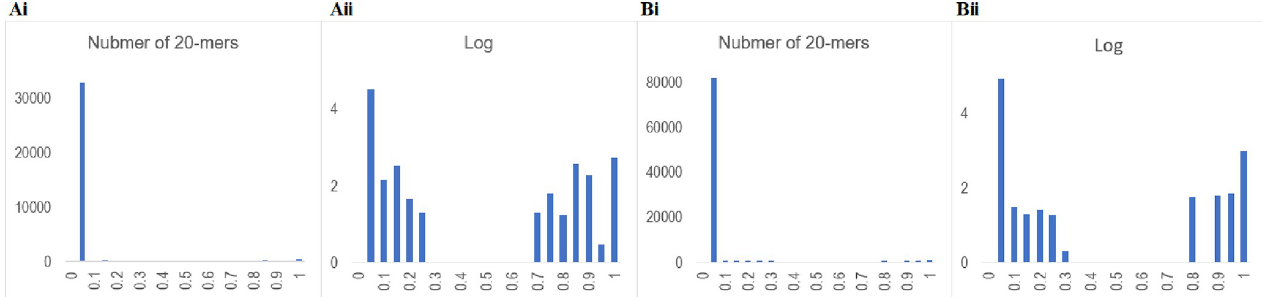
Fig 1. Histogram analysis of 20-mers. (A) Histogram of the level of increase of each 20-mer frequency in the Jan. 2022 population compared to that in the Dec. 19 population. The horizontal axis is divided by the increase level by 0.05. The vertical axis shows normal numbers (i) or logarithms (Log) (ii). Here, nonexistence in the logarithmic display is shown expediently as 0. (B) The level of increase of each 20-mer frequency in the Feb. 2022 population compared to that in the Dec. 19 population is displayed as described in A.